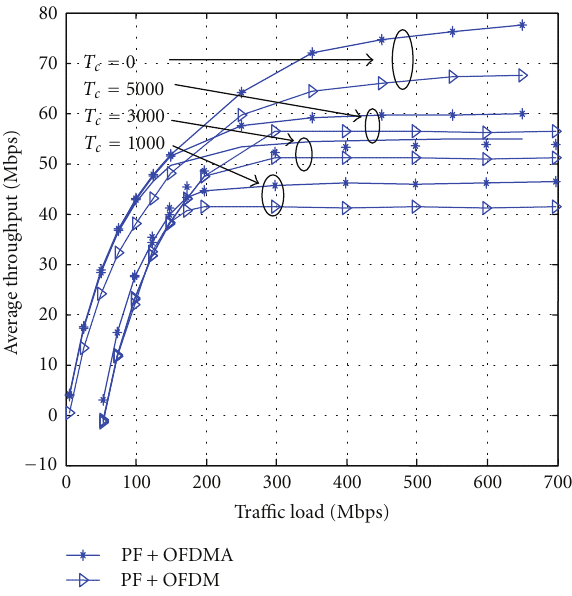
Figure 2: Average throughput of the PF with OFDMA and PF with